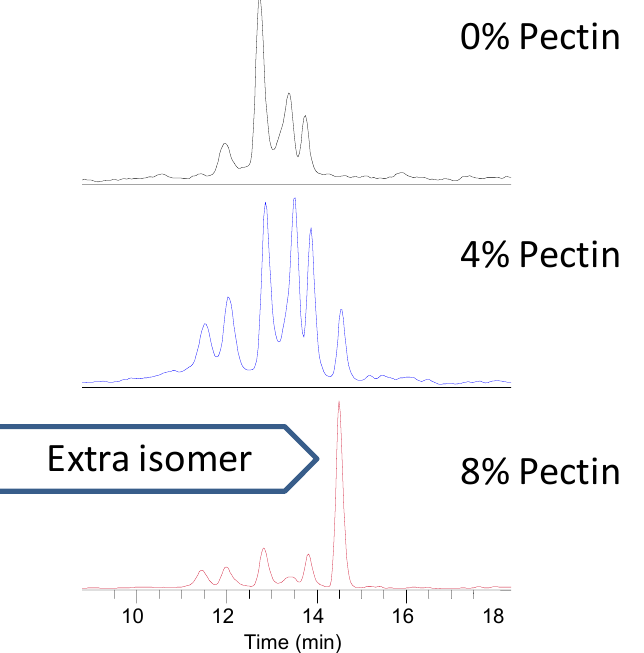
Figure 1. Increased methylation and additional isomers of methyl gallocatechin glucuronide identi- fied in the urine of rats fed blackcurrant and green tea diet with 4 or 8%